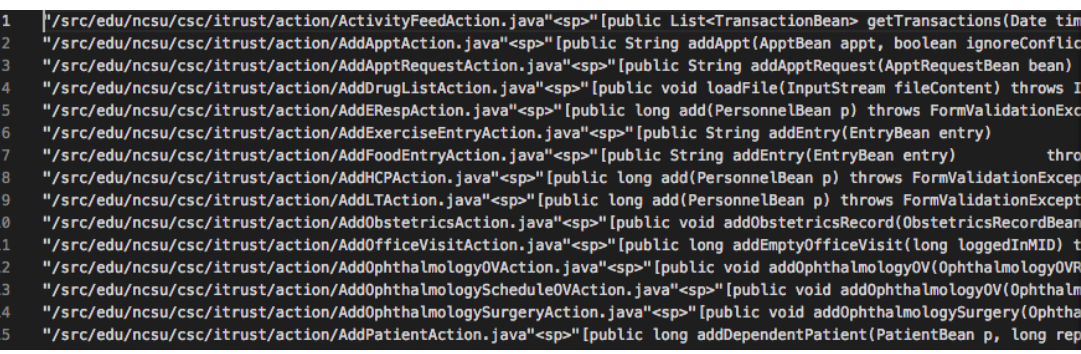
Figure 3: First 15 lines of the method mapping file for iTrust